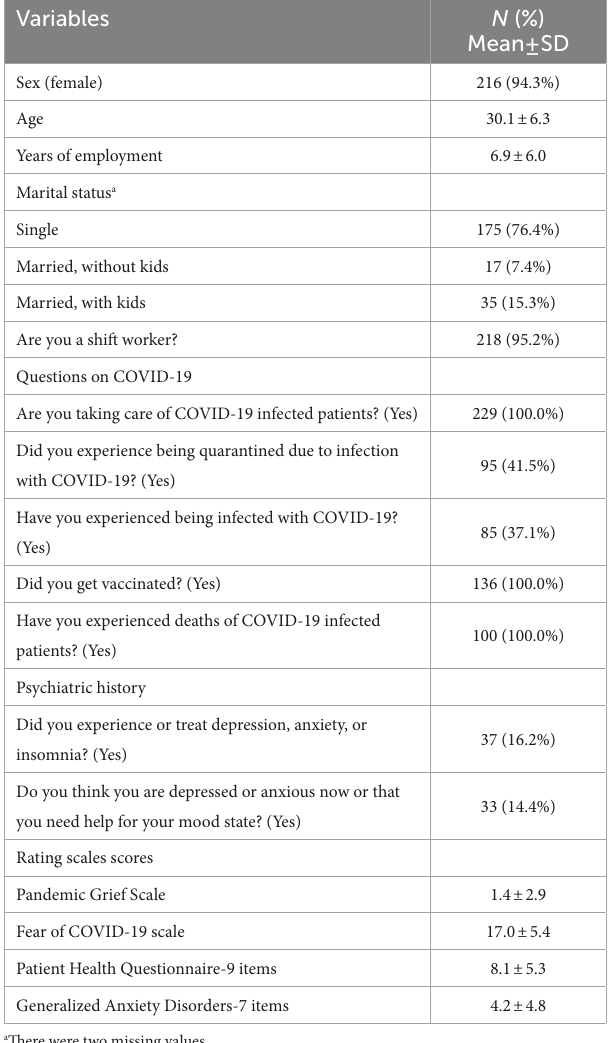
TABLE 1 Clinical characteristics of participants ( N =